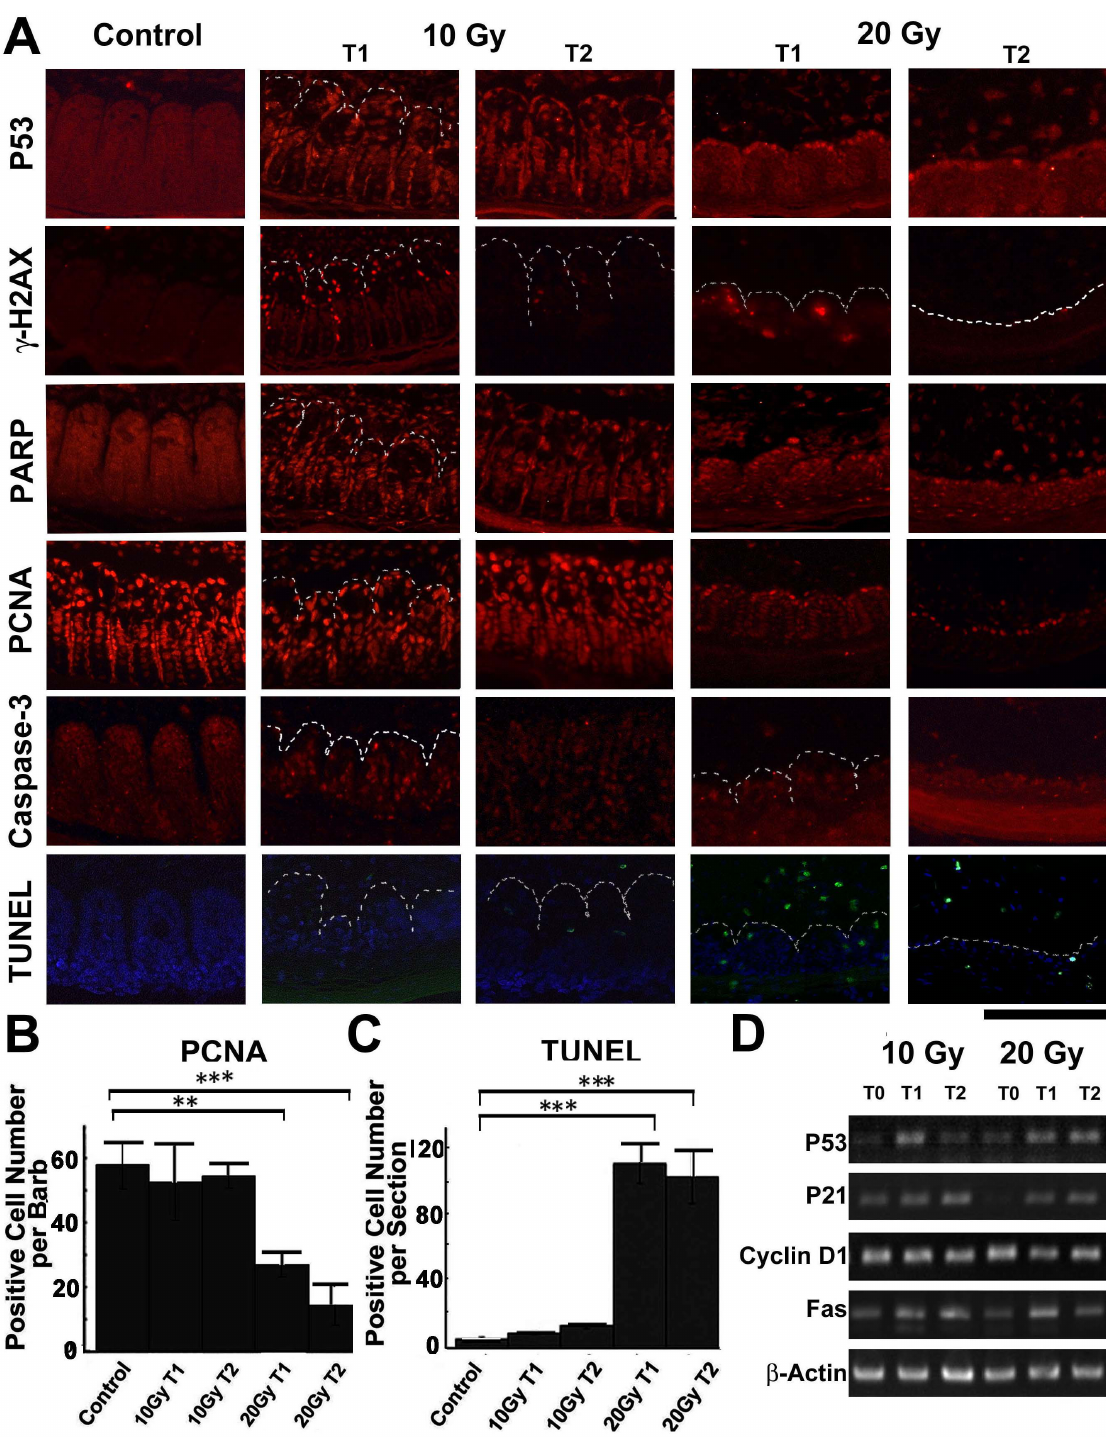
Figure 3. Molecular analysis in the feather follicles after IR exposure. (A) Immunohistochemistry (red) showing P53 activation, gama-H2AX expression, and PARP activation after IR exposure. Cell proliferation is indicated by PCNA staining, and cell apoptosis is monitored by Caspase-3 staining and TUNEL analysis (green). (B–C) Quantification of PCNA staining and TUNEL analysis. Significant decrease in PCNA staining is noticed after 20 Gy treatment, when TUNEL staining is also the most significant. **, p , 0.01; ***, p , 0.001. (D) RT-PCR analysis of gene expression in the feather follicle. T0, control samples before IR; T1, 1 day post-IR; T2, 2 days post-IR. Bar=100 m m.